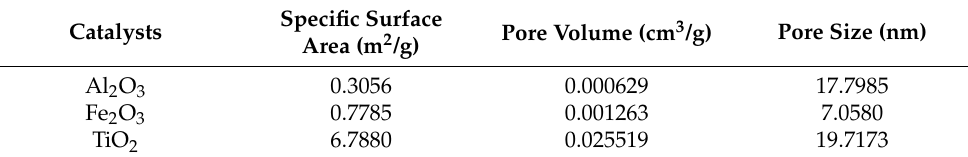
Table 1. BET data analysis of the three catalyst samples. Catalysts